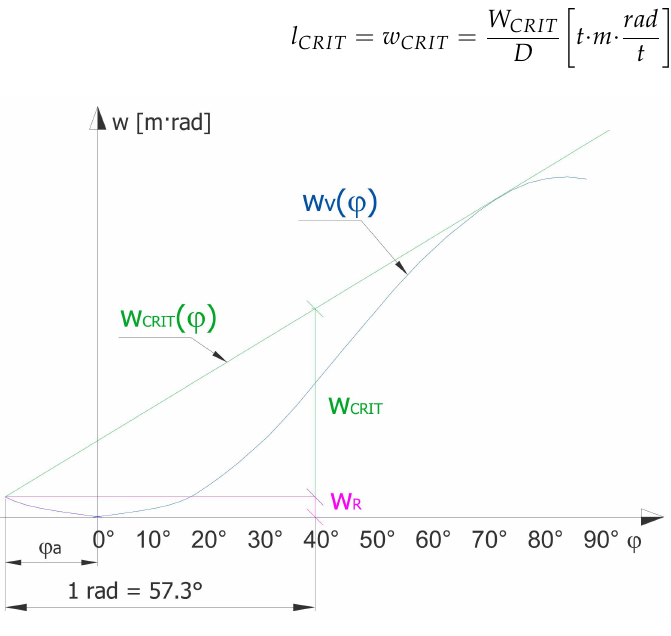
Figure 7. Critical work— W CRIT